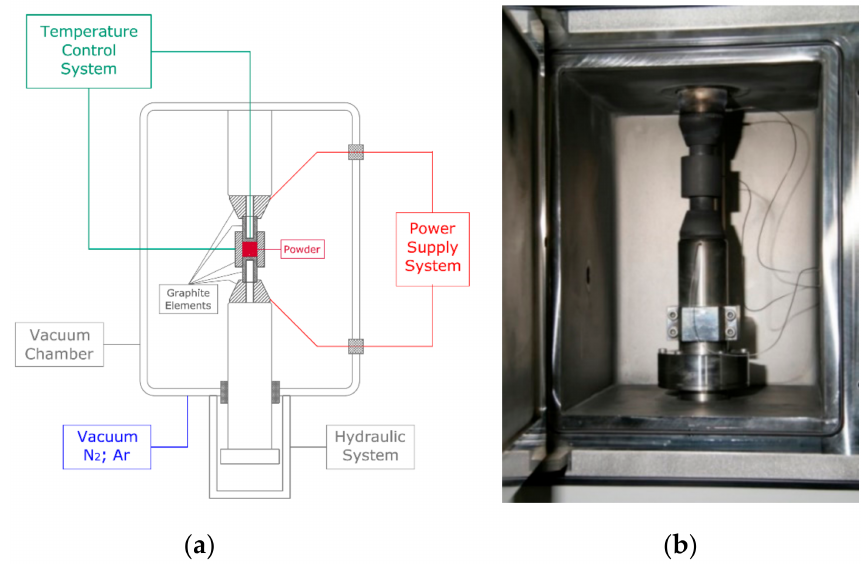
Figure 1. Spark plasma sintering (SPS) system: ( a ) basic configuration and ( b ) vacuum and gas